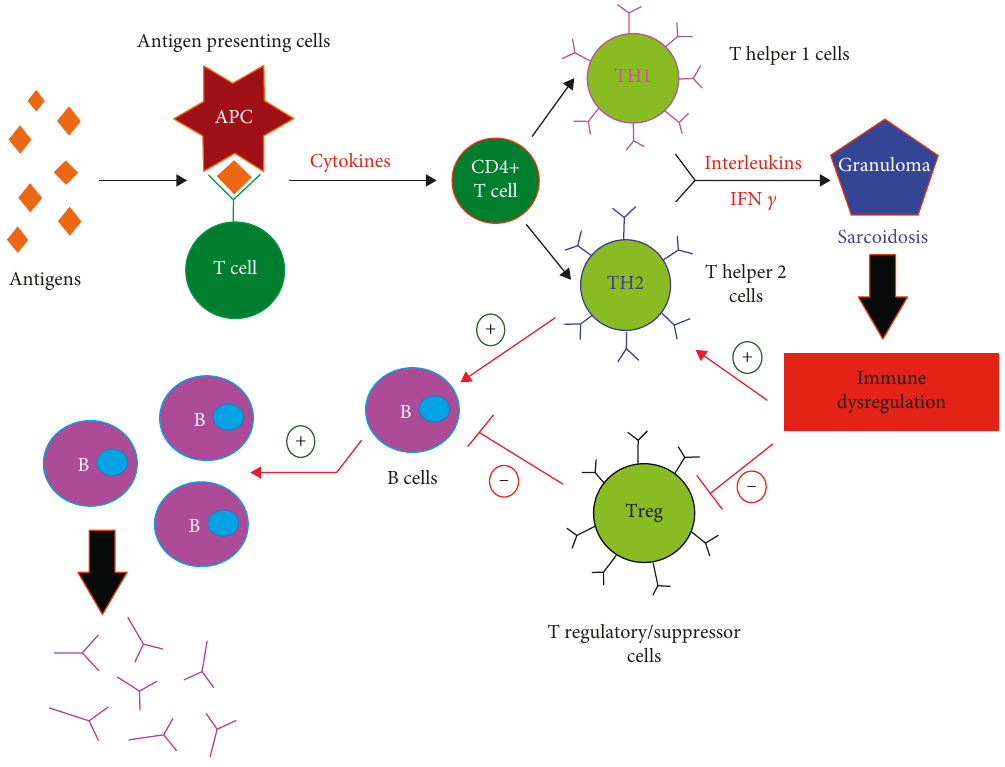
Figure 2: Proposed pathogenesis of MGUS in patients with sarcoidosis. Abbreviations: APC (Antigen-presenting cells), T cell (T lym- phocytes), CD4+ Tcell (cluster differentiation 4 positive Tcell), TH1 (T Helper 1 cells), TH2 (T Helper 2 cells), IFN c (Interferon gamma), Treg (Regulatory T cells), B Cells (B